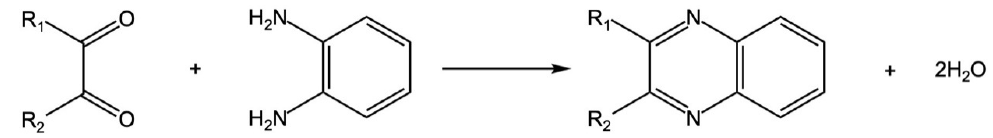
Figure 1. The reaction equation of OPD and α -DCs. Figure 5. Reverse aldol condensation of 3-DG to produce MGO.